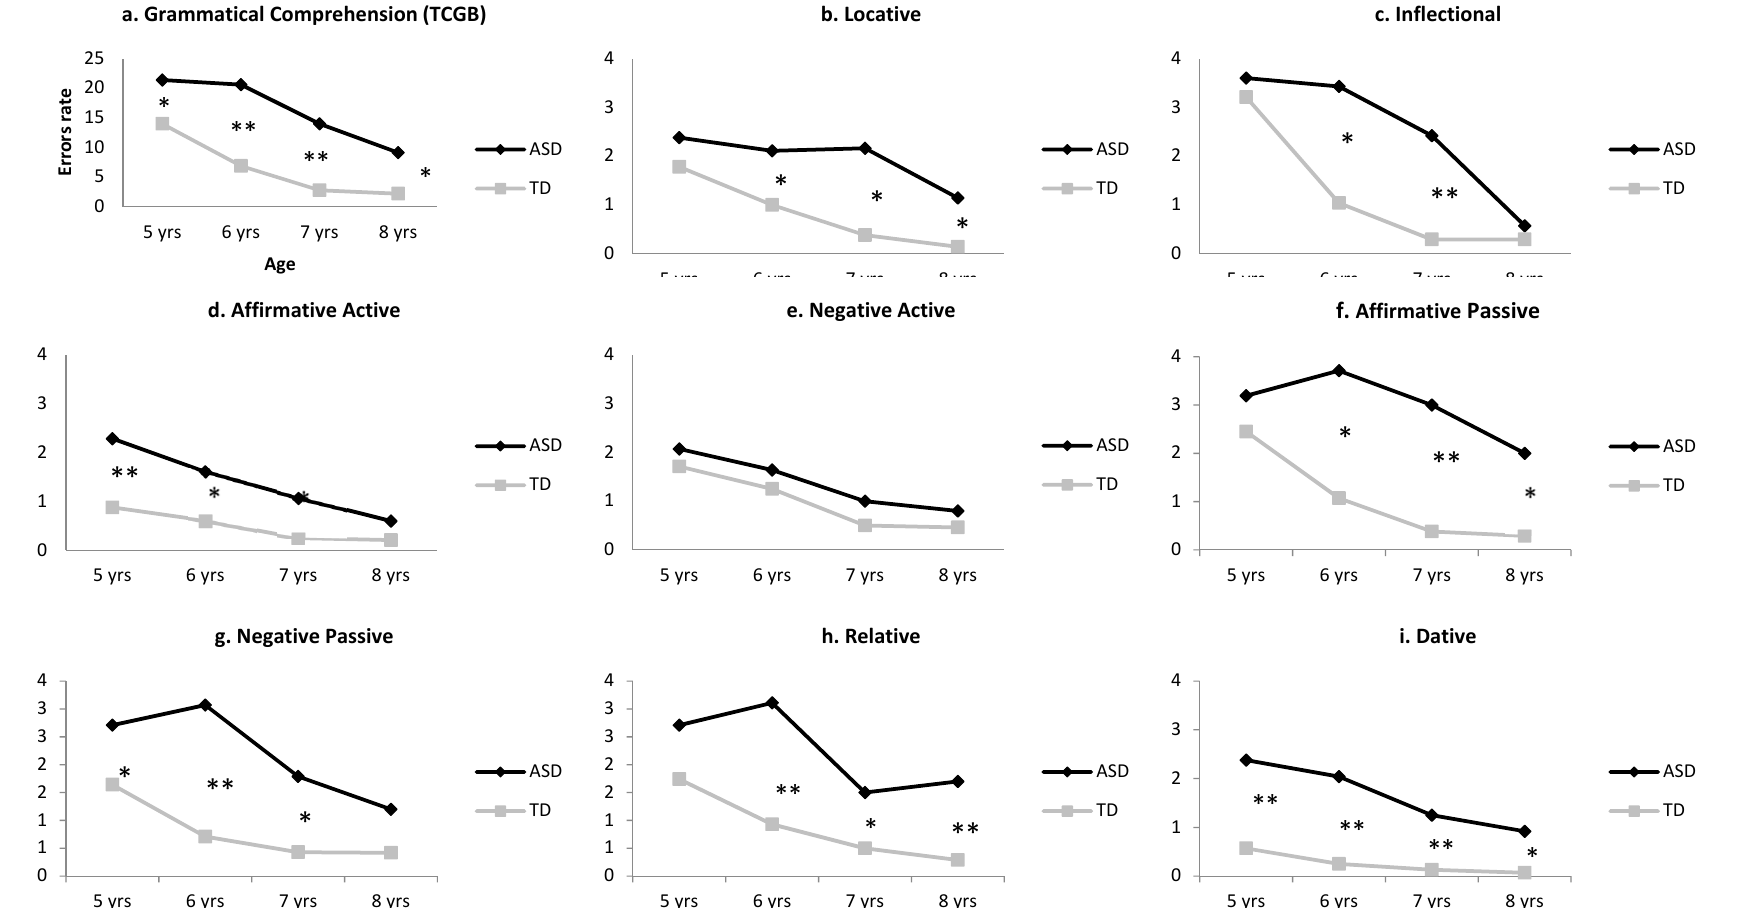
Figure 1. ASD and TD children’s total ( a ) and single clause type ( b – i ) error scores (* p ≤ 0.05; ** p ≤ 0.001). Abbreviation: yrs: years.